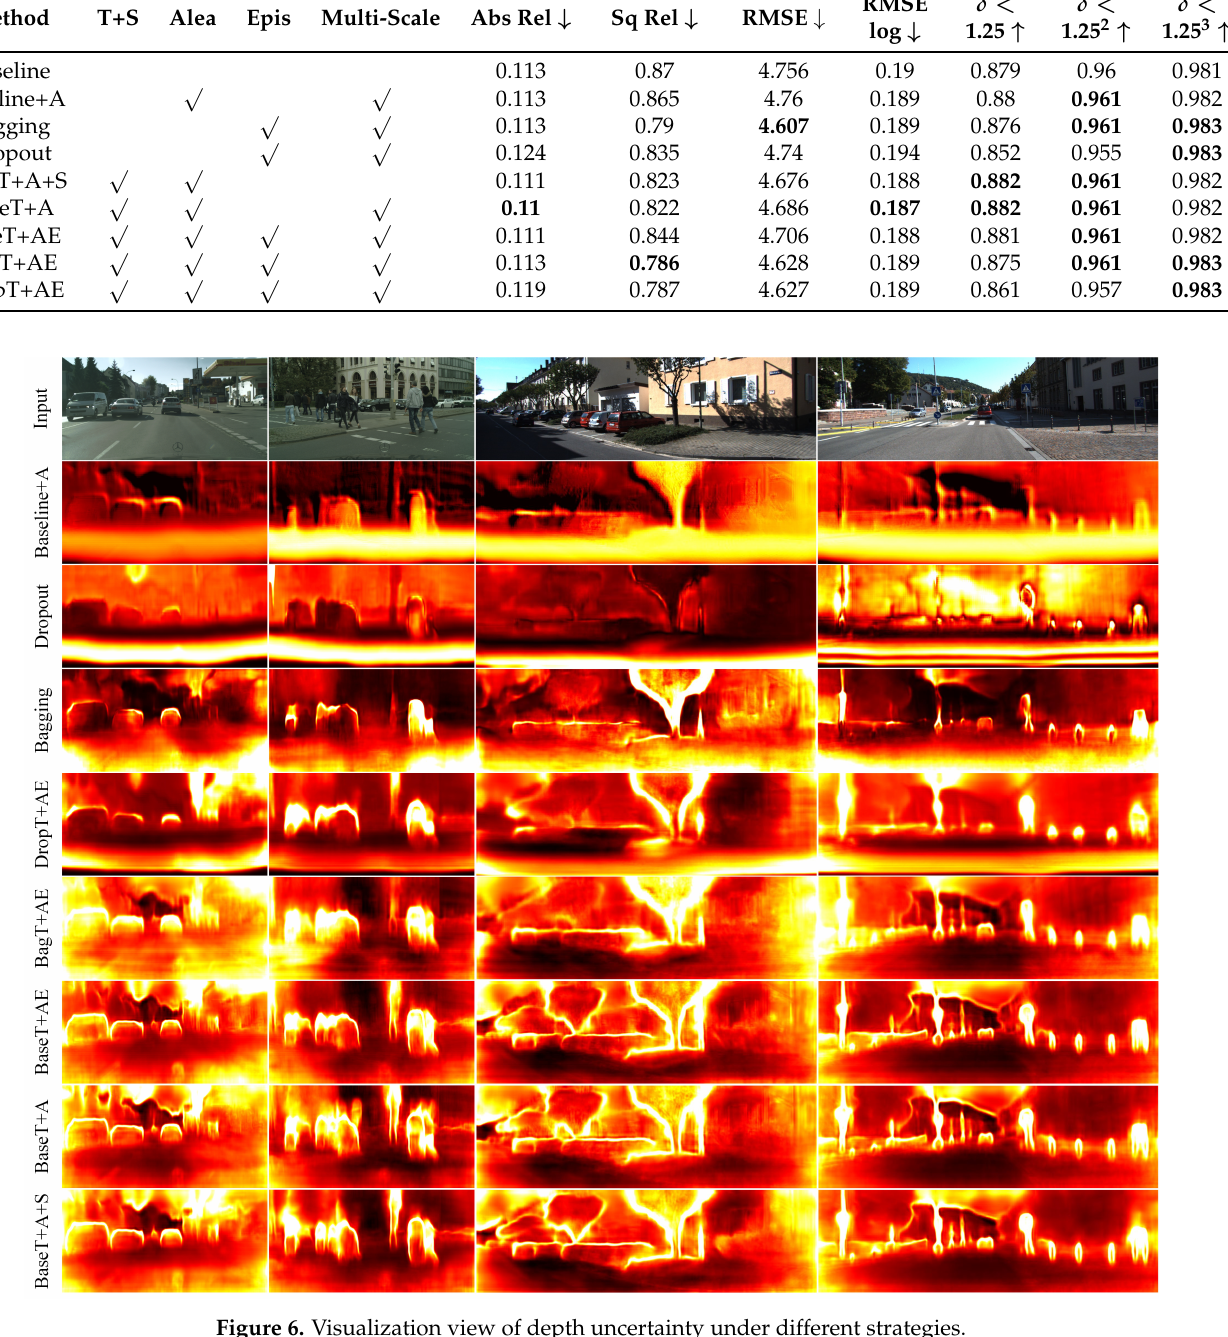
Figure 6. Visualization view of depth uncertainty under different